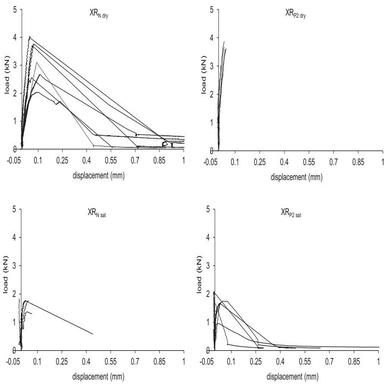
Flexural load–displacement diagrams of tested XR specimens: dry mass (above) and saturated (bellow) conditions.